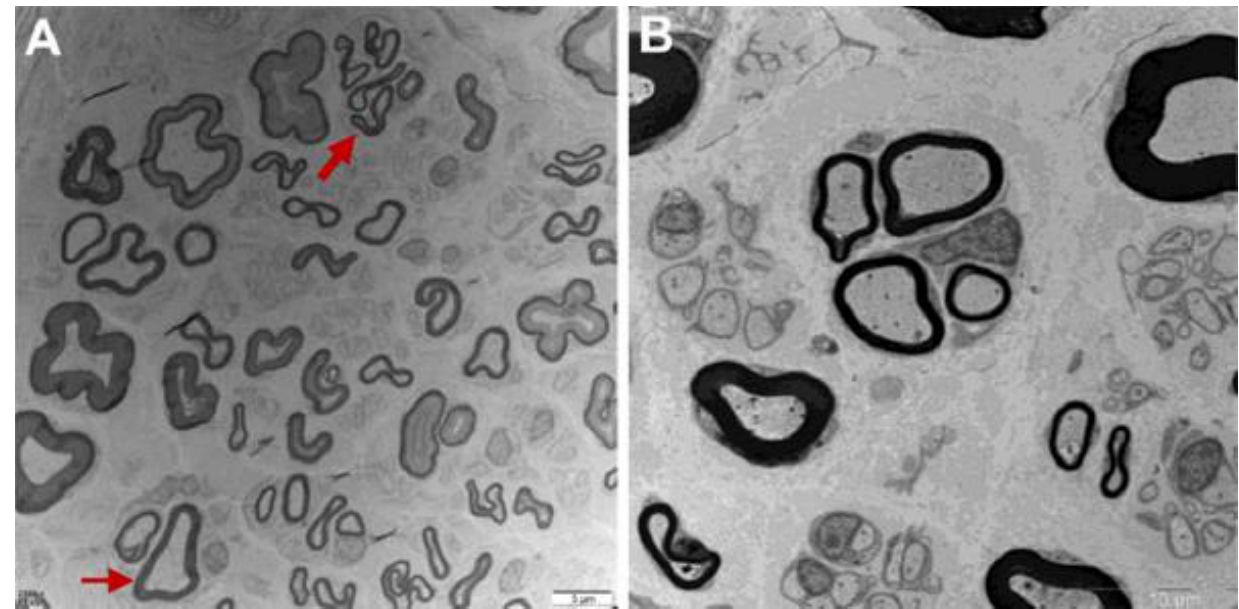
Figure 2. Sural nerve biopsy of F1-II-2 ( A ) and F2-II-7 ( B ). ( A ) Mild to moderate decrease of large myelinated fibers, clusters of regeneration (thick arrow) and demyelination (thin arrow) (bar = 5 μm). ( B ) Decrease of myelinated nerve fibers with some nerve fiber regeneration (bar = 10 μm). WES was used for pathogenic gene screening. A heterozygous c.C544G